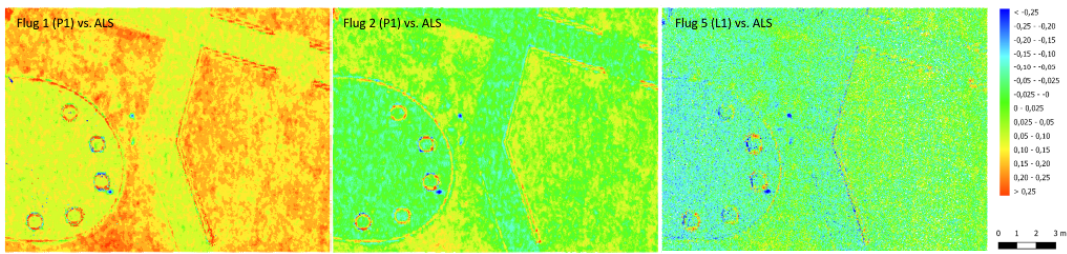
Figure 13 . Comparison of point clouds of flight 2 (P1) to point clouds of flights 3, 4 and 5 (each L1) on test area 3.